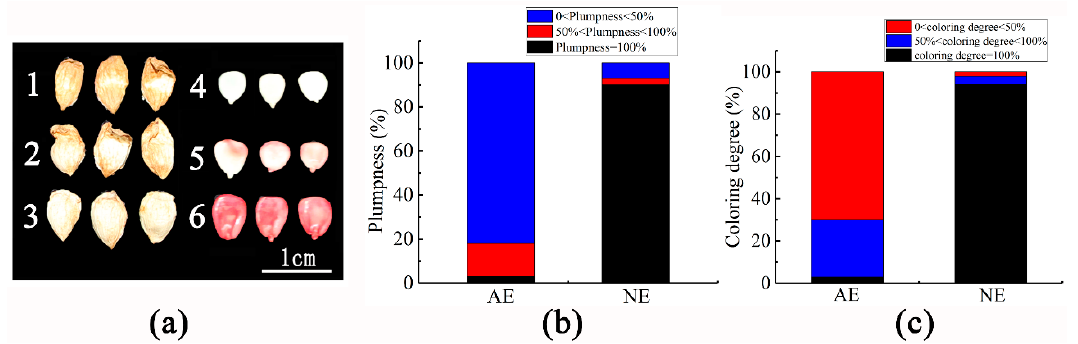
Figure 1. The embryos vigor of abscission and non-abscission fruit. ( a ) 1, 2, and 3 represent different plumpness, and 4 , 5 , and 6 represent the coloring degree corresponding to different plumpness. ( b ), The stacked figure of different plumpness. ( c ), The stacked figure of different coloring degree. AE, abscission embryo; NE, non-abscission embryo.